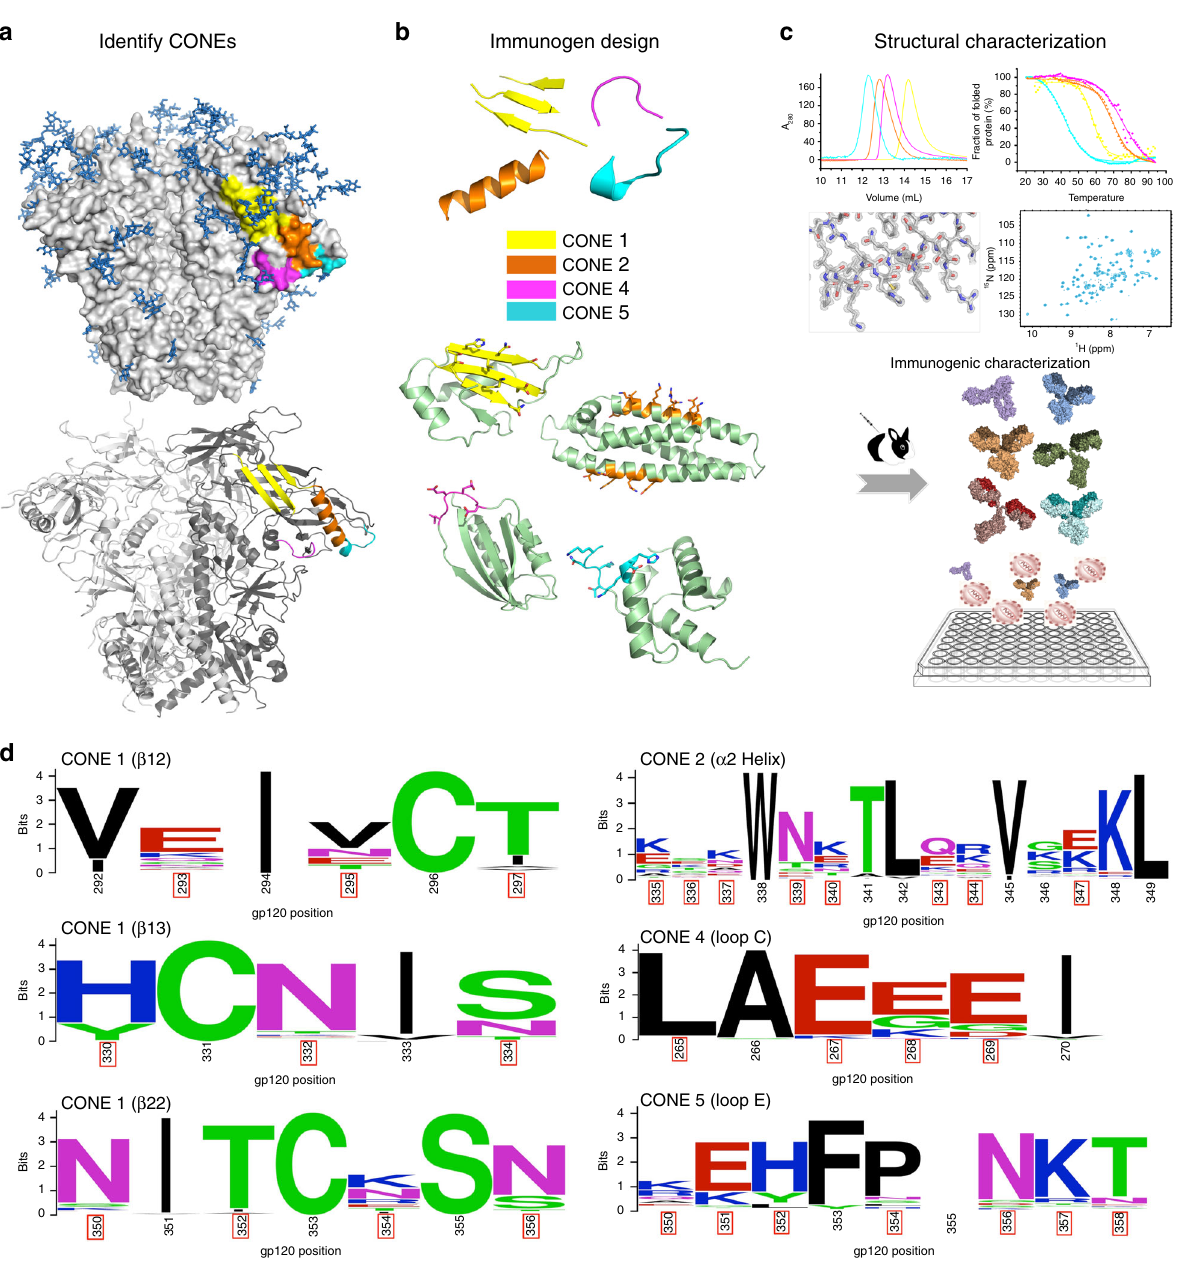
Fig. 1 Rational design of HIV-1 immunogens and elicitation of antibodies targeting the CONEs. a Fully glycosylated Env (upper panel) encodes a shield of glycan (dark blue) masking its conserved surface. In underglycosylated Env (lower panel) the carbohydrate-occluded neutralization epitopes (CONEs) are exposed. The transmitted HIV-1 viruses isolated from infected individuals are typically missing at least one carbohydrate in one CONE (shown in colors, see key in panel b ). b Small protein mimics of the CONEs, designed by epitope transplantation, can serve as potential immunogens to focus the antibody response towards CONEs. c The experimental work fl ow includes biophysical characterization (circular dichroism, size exclusion chromatography), structural characterization (X-ray crystallography, NMR) of designed proteins, and immunogenic evaluation in animal models. d Consensus protein sequences of the CONEs. The site convergence data were derived from 183 Env sequences of clade C HIV-1 isolated from acutely infected patients. The solvent-exposed resides in Env are marked with red